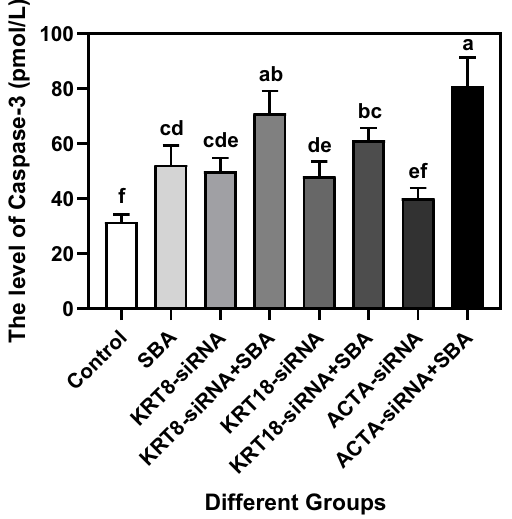
Figure 14. The determination of the caspase-3 activity in different treatments. After being treated for 24 h, the caspase-3 activities in different treatments (Control treatment (T1); SBA treatment (T9); KRT8-siRNA treatment (T2); KRT8-siRNA + SBA treatment (T10); KRT18-siRNA treatment (T3); KRT18-siRNA + SBA treatment (T11); ACTA-siRNA treatment (T4); and ACTA-siRNA + SBA treatment (T12)) were determined using double antibody sandwich method of ELISA. Each column represents the mean ± SEM of three independent experiments. Different lowercase letters indicate the significance of differences between different treatment groups ( p < 0.05).